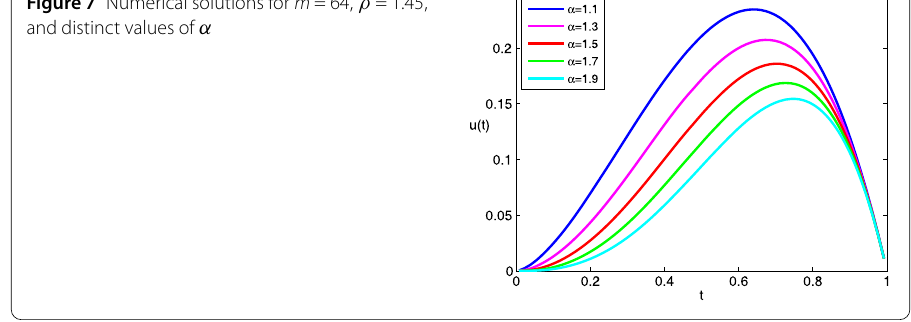
Figure 8 Numerical solutions for m = 64, α = 1.55, and different values of